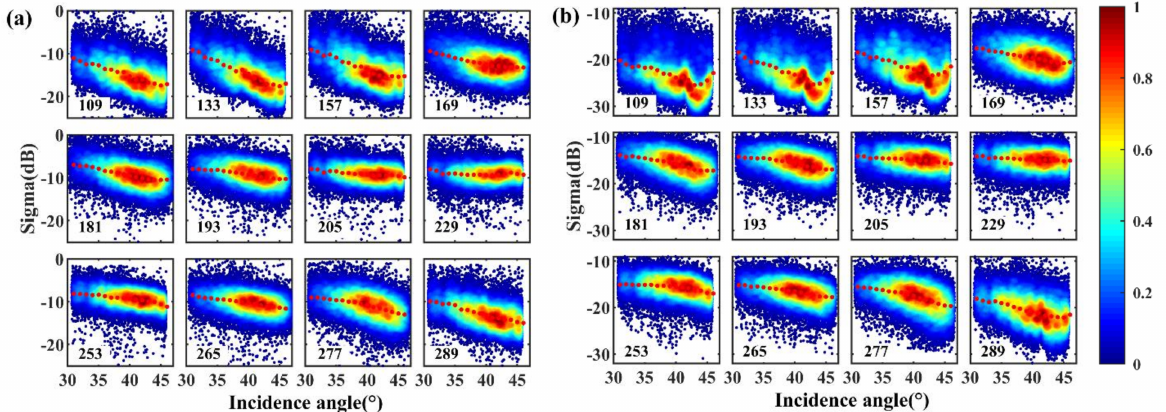
Figure 3. The statistical relationship between radar backscattering coefficient ( σ 0 ) and the incident angle from April to October. ( a ) VV polarization; ( b ) VH polarization.